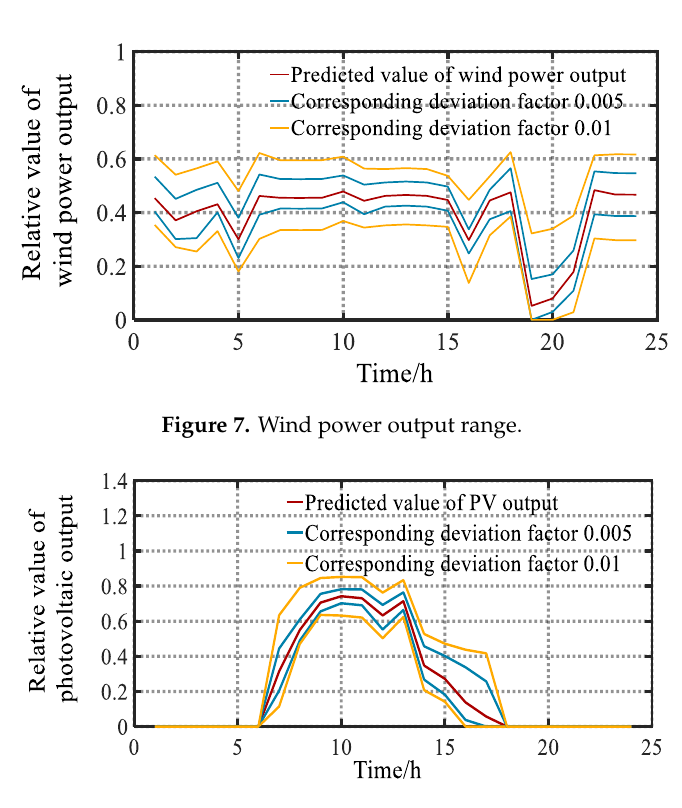
Figure 8. Photo voltaic output range.